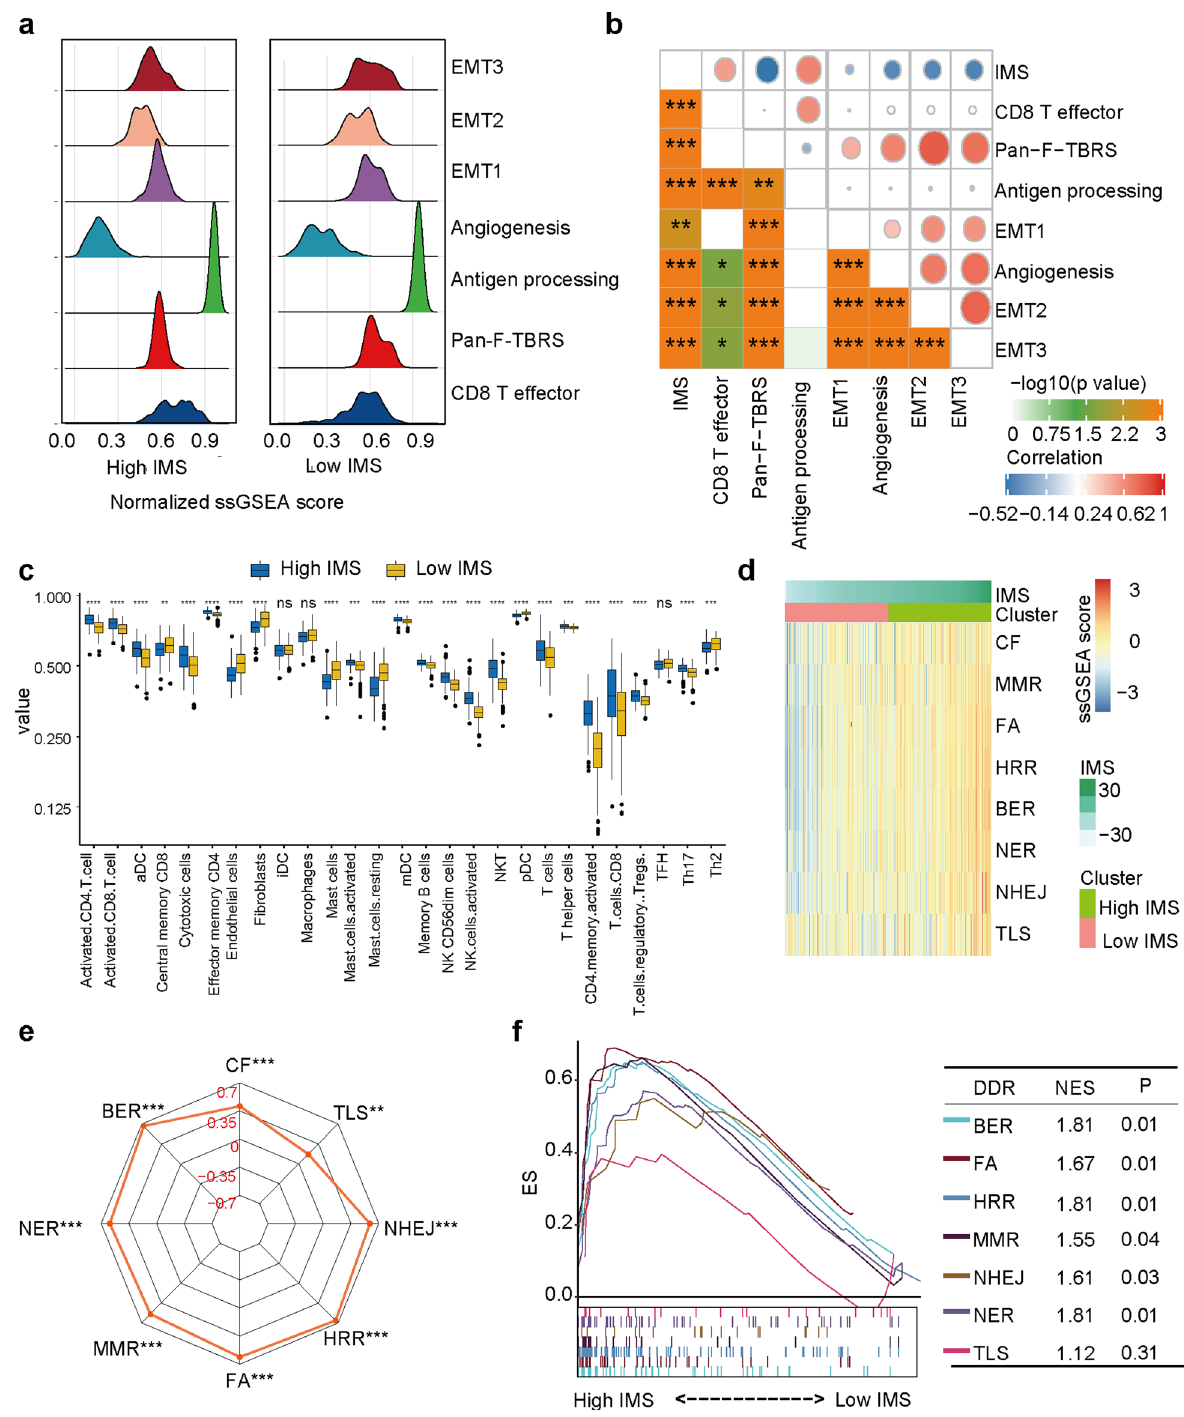
Fig. 2 The effect of the IMS in gastric cancer (ACRG cohort). a Differences in immune-related pathways and stroma-activated pathways, including the EMT, TGF-beta, angiogenesis, effector CD8 T cell, and antigen presentation pathways, between the high and low IMS groups (Wilcoxon test). b The relationship between the signature scores of immune-related pathways and stroma-activated pathways and the IMS (Spearman analysis). c The differential expression of 27 survival-related immune cell types in patients with high and low IMS. The central line represents the median value. The bottom and top of the boxes are the 25th and 75th percentiles (interquartile range). The whiskers encompass 1.5 times the interquartile range. d Heatmap showing the enrichment scores of eight DNA damage repair (DDR) pathways in gastric cancer samples. e Correlation analysis between the enrichment scores of the eight DNA pathways and the IMS (Spearman analysis). f GSEA of DDR pathways for the high IMS group versus the low IMS group. * P < 0.05, ** P < 0.01, *** P < 0.001, **** P <